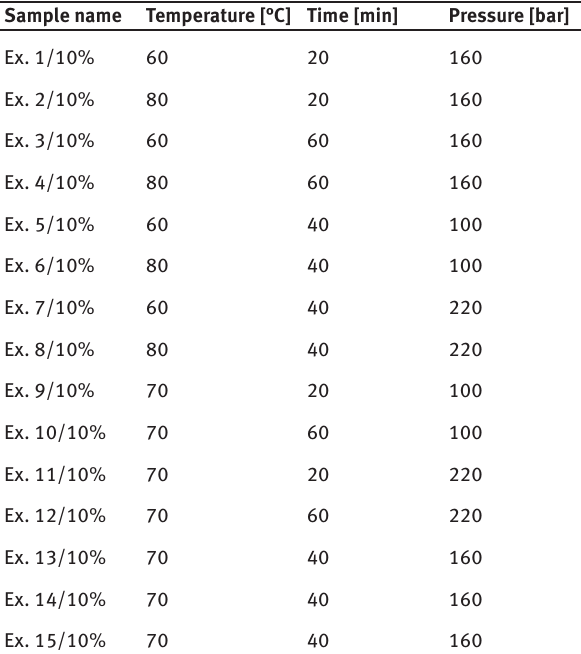
Table 2: Conditions of supercritical carbon dioxide extraction for 10% ethanol